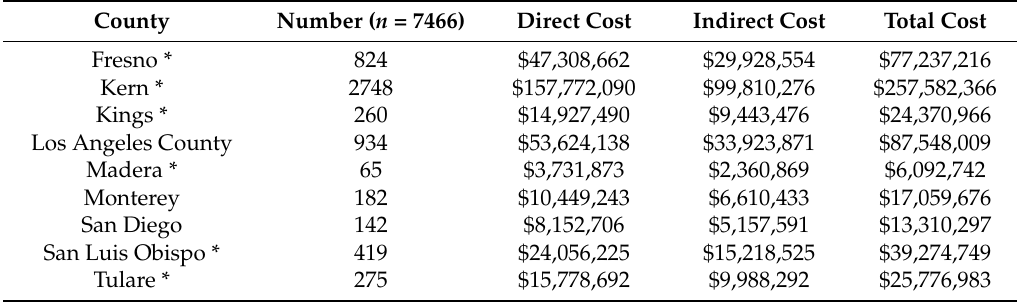
Table 4. Estimated total direct and indirect lifetime costs, stratified by endemic counties and counties with >100 reported coccidioidomycosis (CM) cases in 2017 in